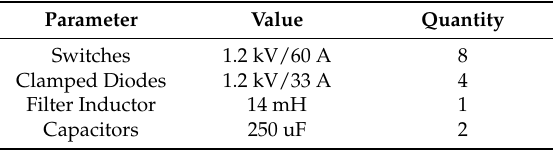
Table 2. Parameter specifications of the NPC inverter.